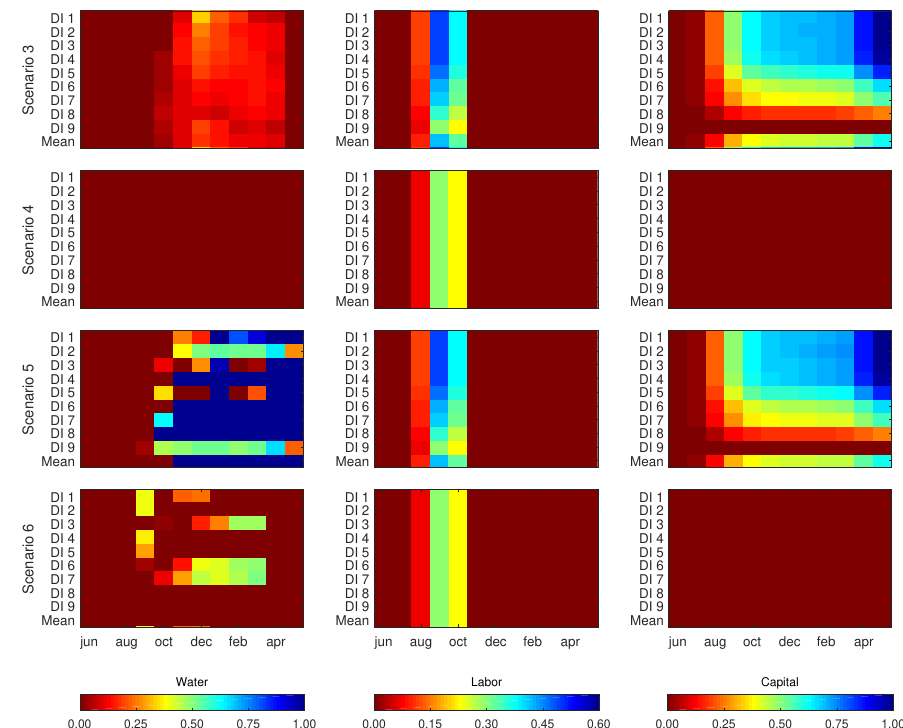
Figure 11. Monthly limiting resources presented as water, labour, and capital availability for each decile of water supply (DI) and for each monthly scenario (from 3 to 6) for situation b (see Section